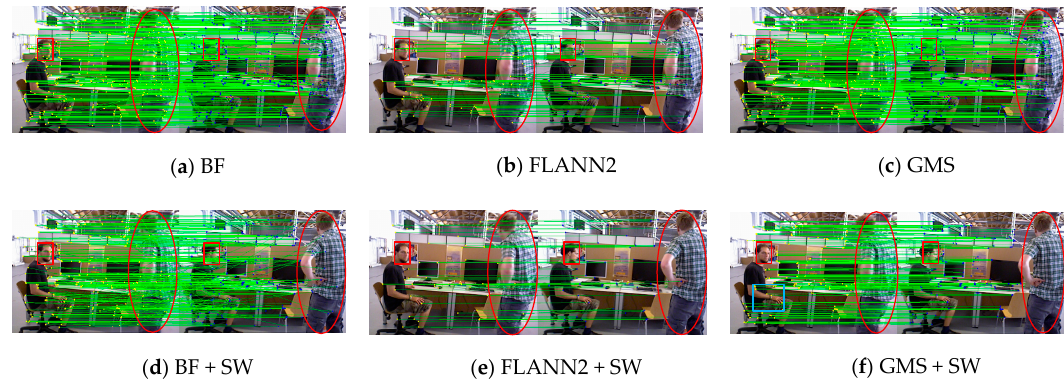
Figure 6. SW represents the sliding window, and the red box/ellipse indicates that the object in the area has moved. ( a – c ) Three matching algorithms use two consecutive frames of images to achieve feature matching on the fr3_walking_xyz dataset in TUM. ( d – f ) These algorithms combine the sliding window model to perform feature matching between the first frame image and the nth frame image. GMS with SW can get the best feature matching result and eliminate the influence of moving objects in the red area. Table 1. Feature point matching time and